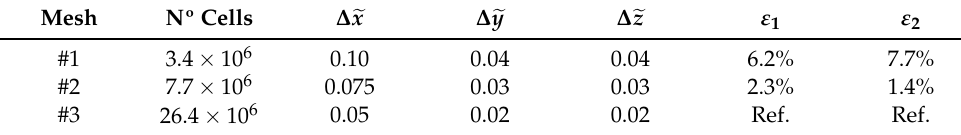
Table 1. Mesh sensitivity analysis for the case TR = W and Re =